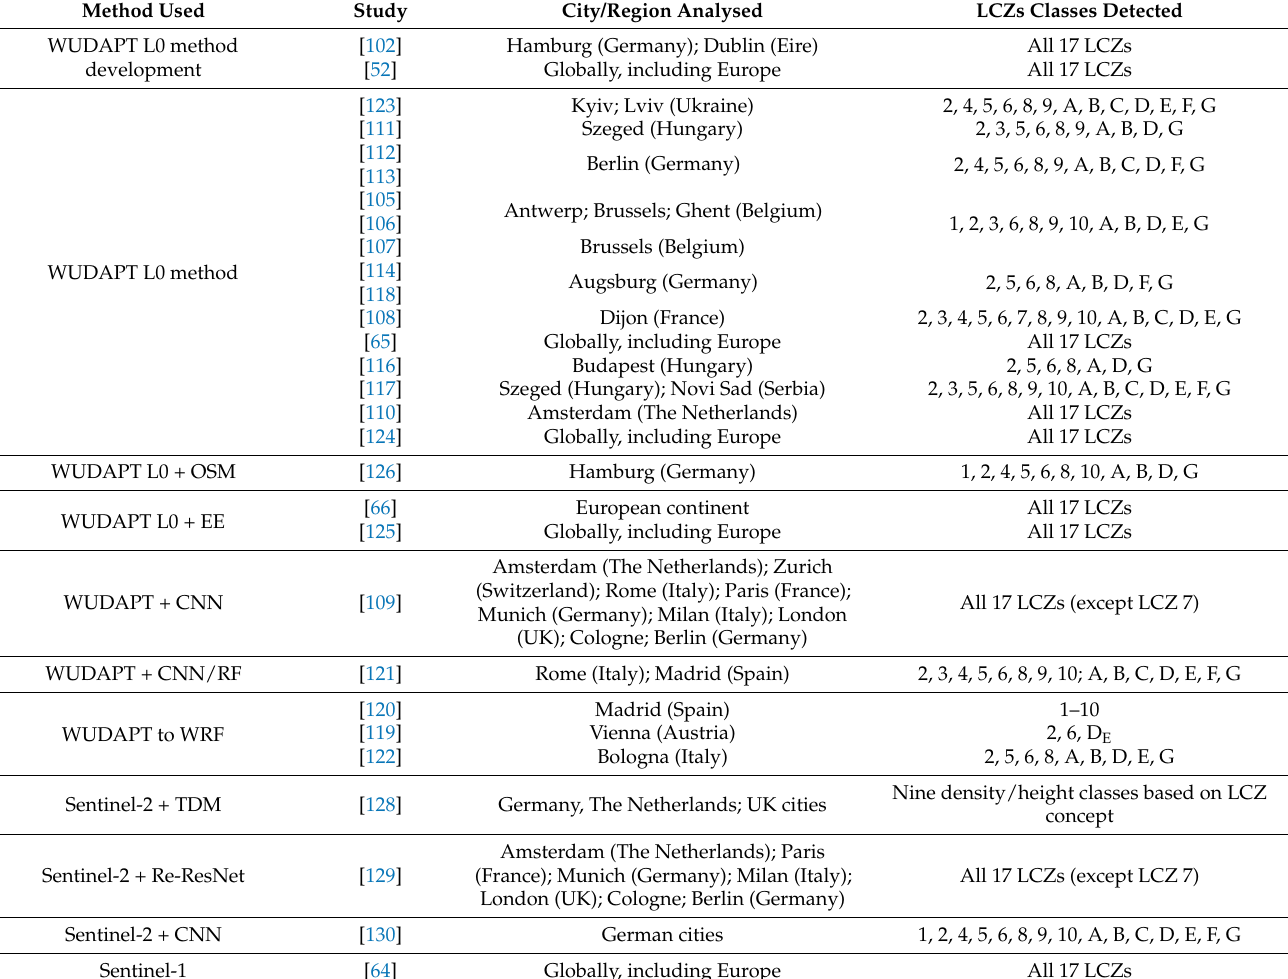
Table 3. Remote sensing imagery-based methods for LCZ mapping derived from the studies identified in this review. Method